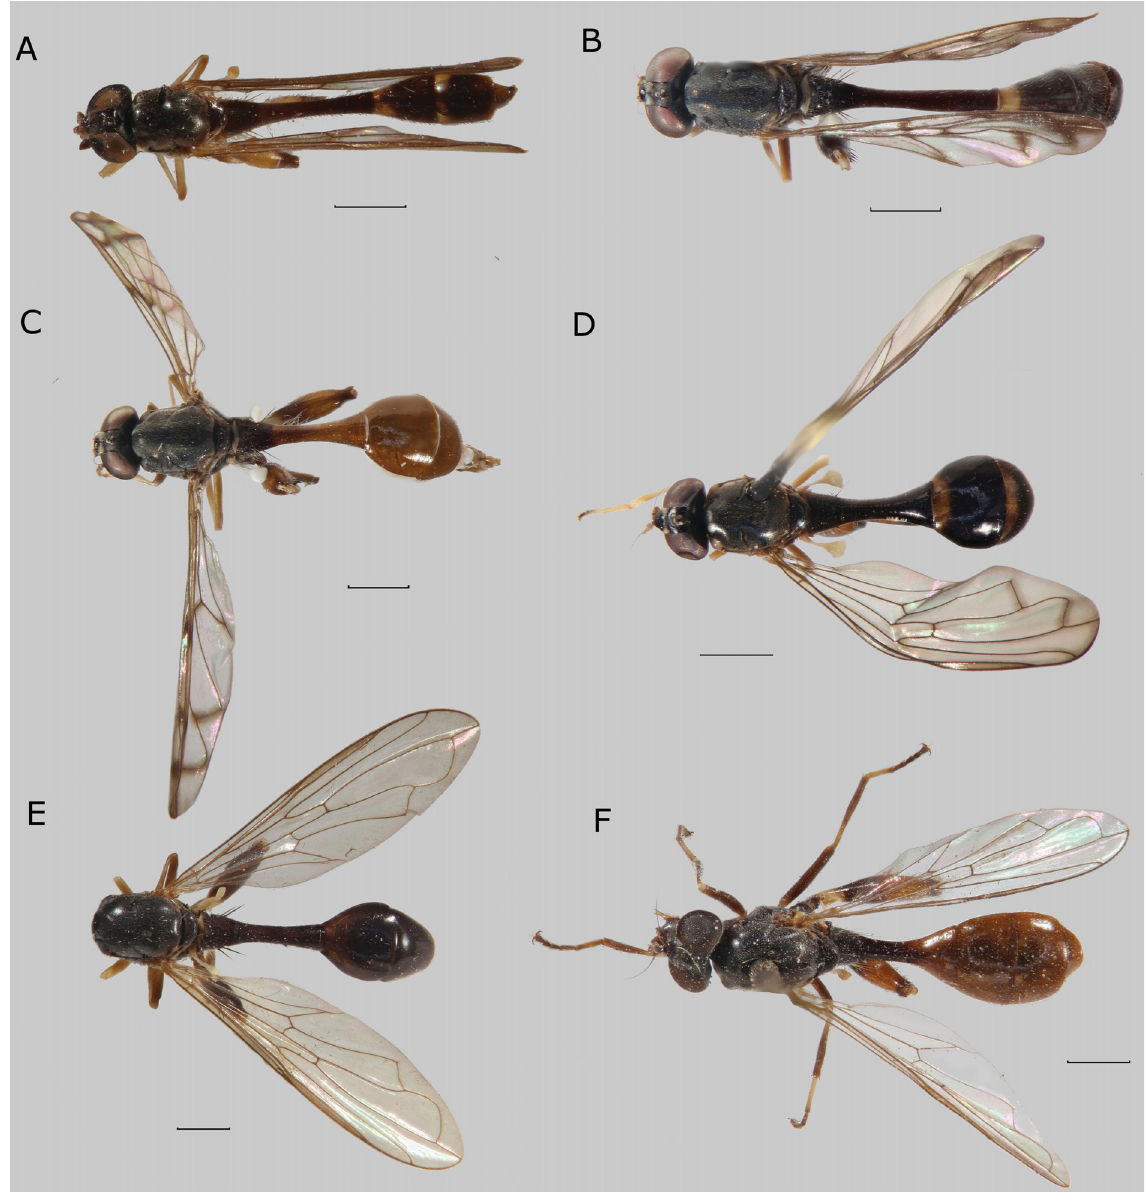
Fig. 90. Habitus, dorsal view. A . Sphegina (Asiosphegina) simplex Hippa, van Steenis & Mutin, 2015, paratype, ♂ , Myanmar. B . S. ( A.) strigil lata sp. nov., paratype, ♂ , Vietnam. C . S. (A.) strigillata sp. nov., paratype, ♀ , Vietnam. D . S. ( A. ) taiwanensis sp. nov., paratype, ♀ , Taiwan. E . S. (A.) trichaeta Hippa, van Steenis & Mutin, 2015, paratype, ♀ , Myanmar. F . S. (A.) tricoloripes Brunetti, 1915, ♀ , India. Scale bars = 1.0